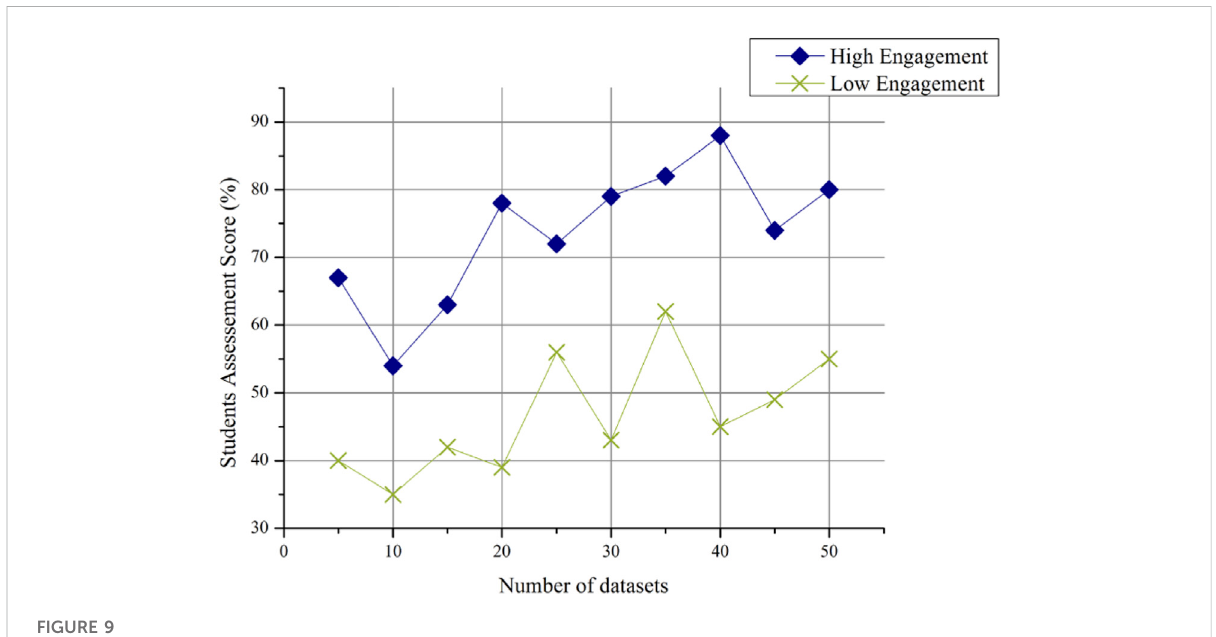
FIGURE 9 Students assessment score.